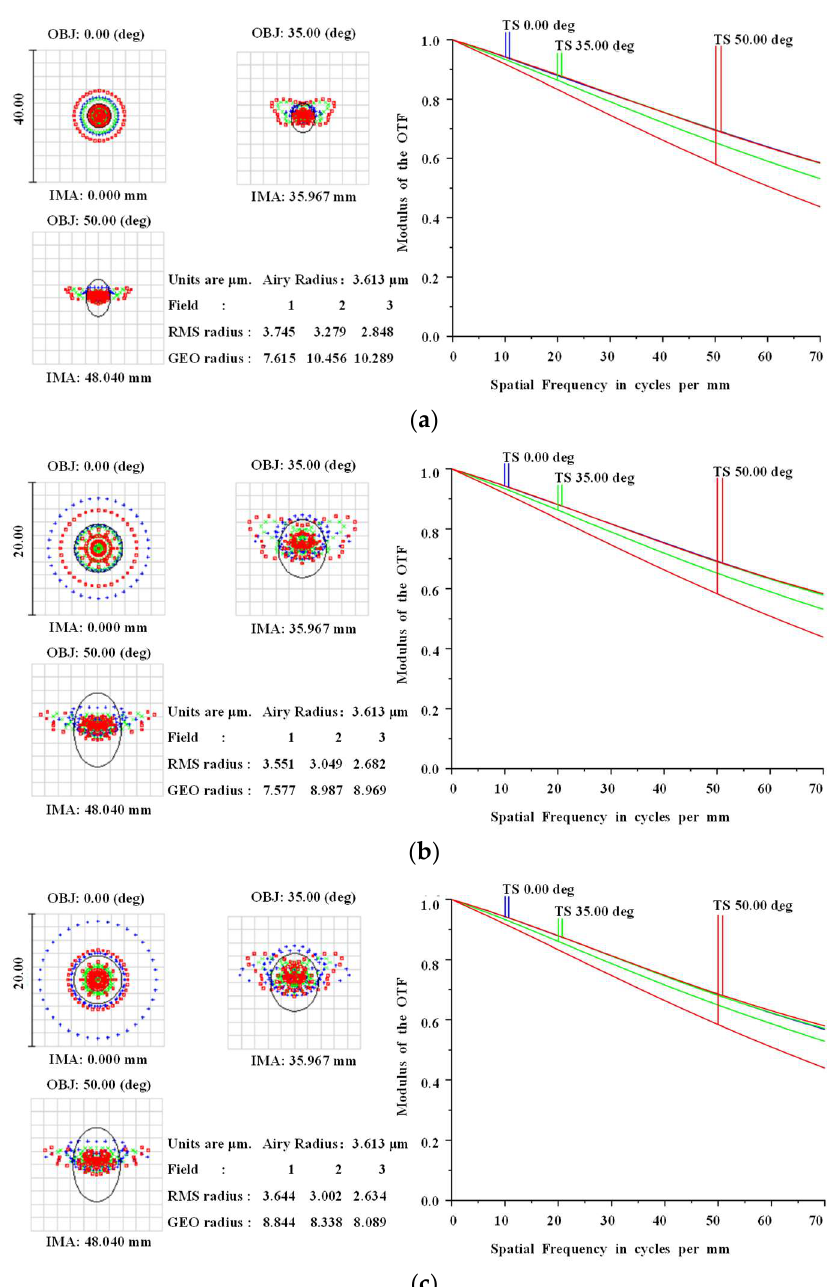
Figure 10. Spot and MTF diagrams of the system at 15 °C ( a ), 20 °C ( b ), and 25 °C ( c ).